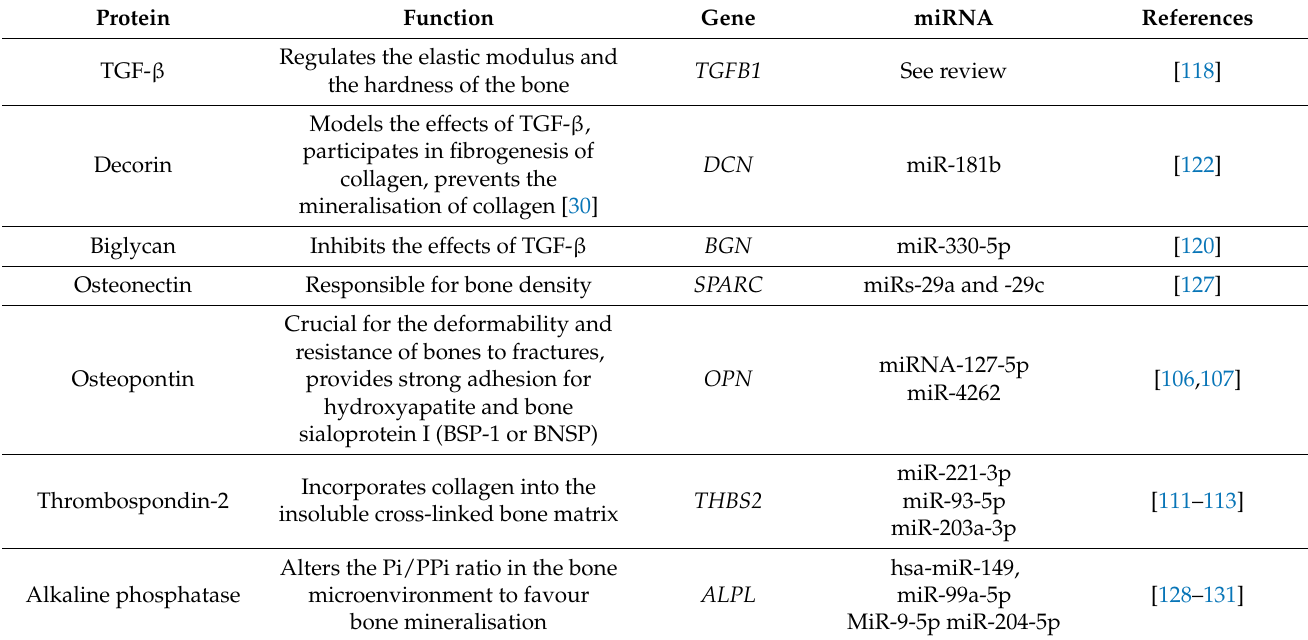
Table 2. Regulation of non-collagenous proteins by